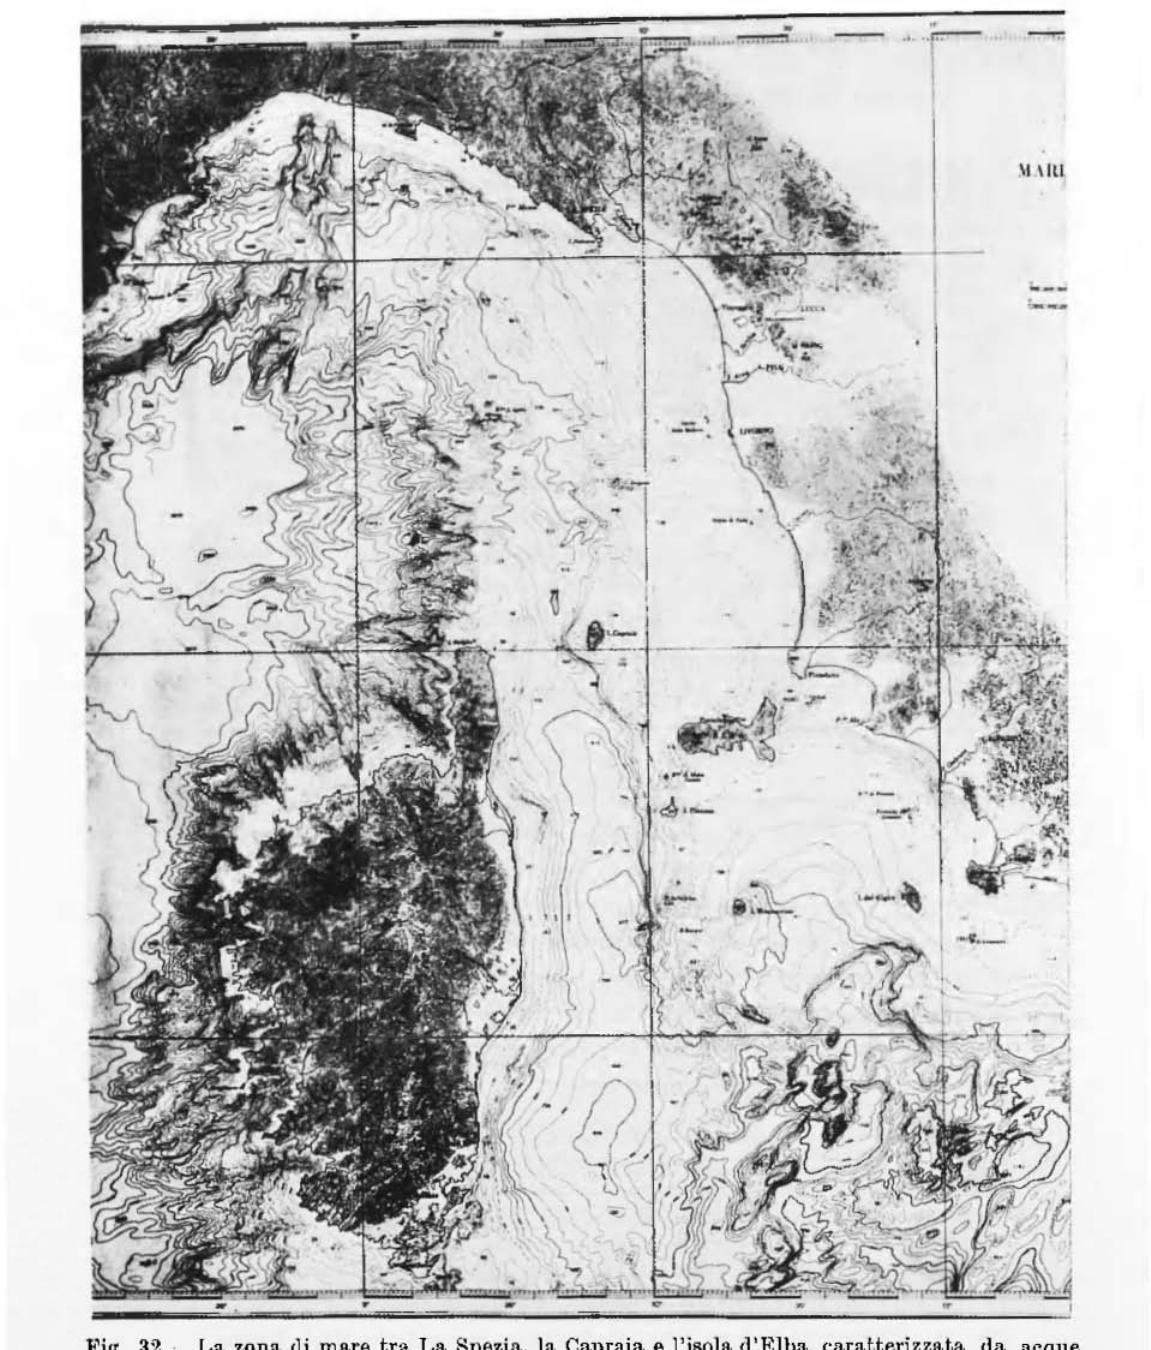
Fig. 32 - 'rise sea strip bet-woon La S,?ezia., Capraia 18-13011(1 alul Elba 1;;lanll, with relat-ively limited depthe, is eonsi(lered the matru: of lIIierosei!\lIIe wi~h r eriod!\ in the order or fl ± I sec. auocia-!:ed to signiftcant ",ave system6, able .. to fee " t he botto m ILnd with a consillera.h!e eaergy load ",hich allows them to propagate at a. distance (from a map or the Hydrographic Institllte or the